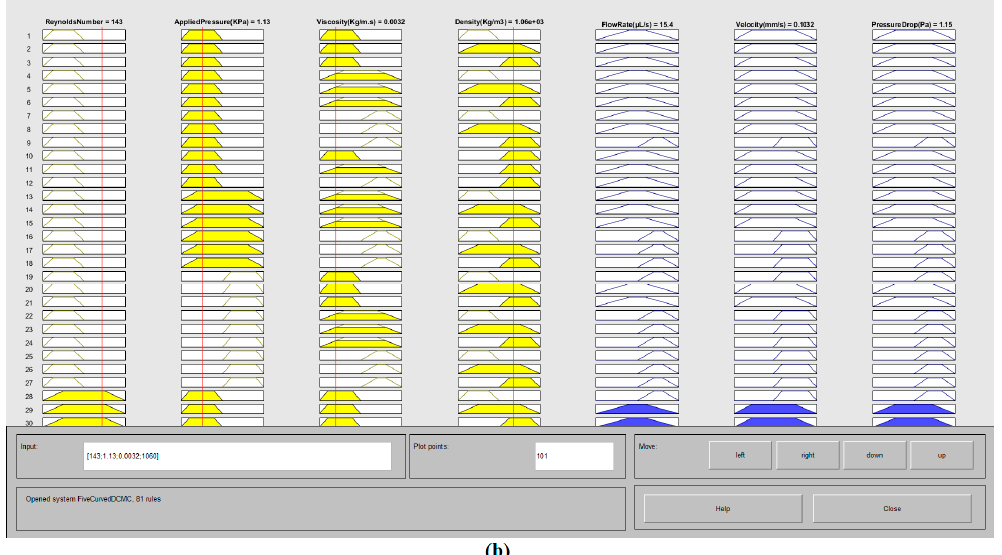
Figure 3. Rule viewer ( a ) For five curved ascending curvilinear micro-channel (5CACMC) ( b ) For five curved descending curvilinear micro-channels (5CDCMC). After the simulation, the three-dimensional graphs obtained for 5CACMC from Fuzzy logic simulation with flow rate as output are shown below in Figure 4.